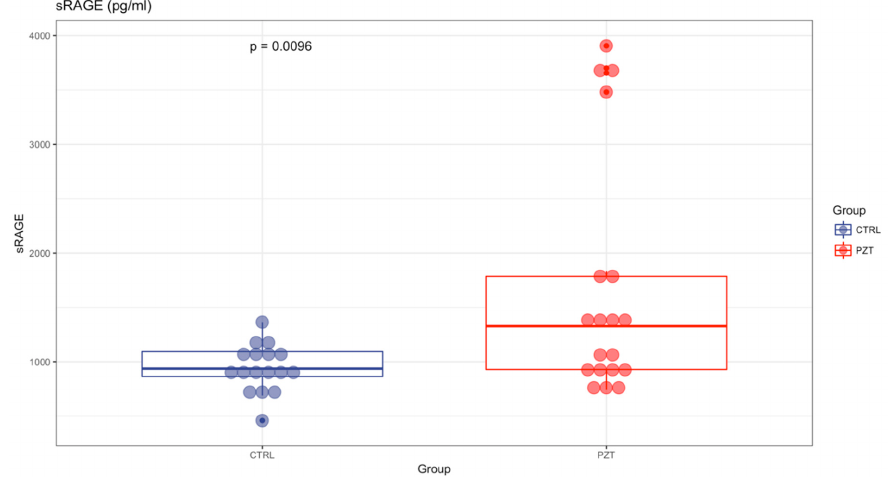
Figure 1. AGE levels were significantly reduced in patients with respect to controls (1.40 ± 0.2 vs 1.52 ± 0.15; p < 0.01).